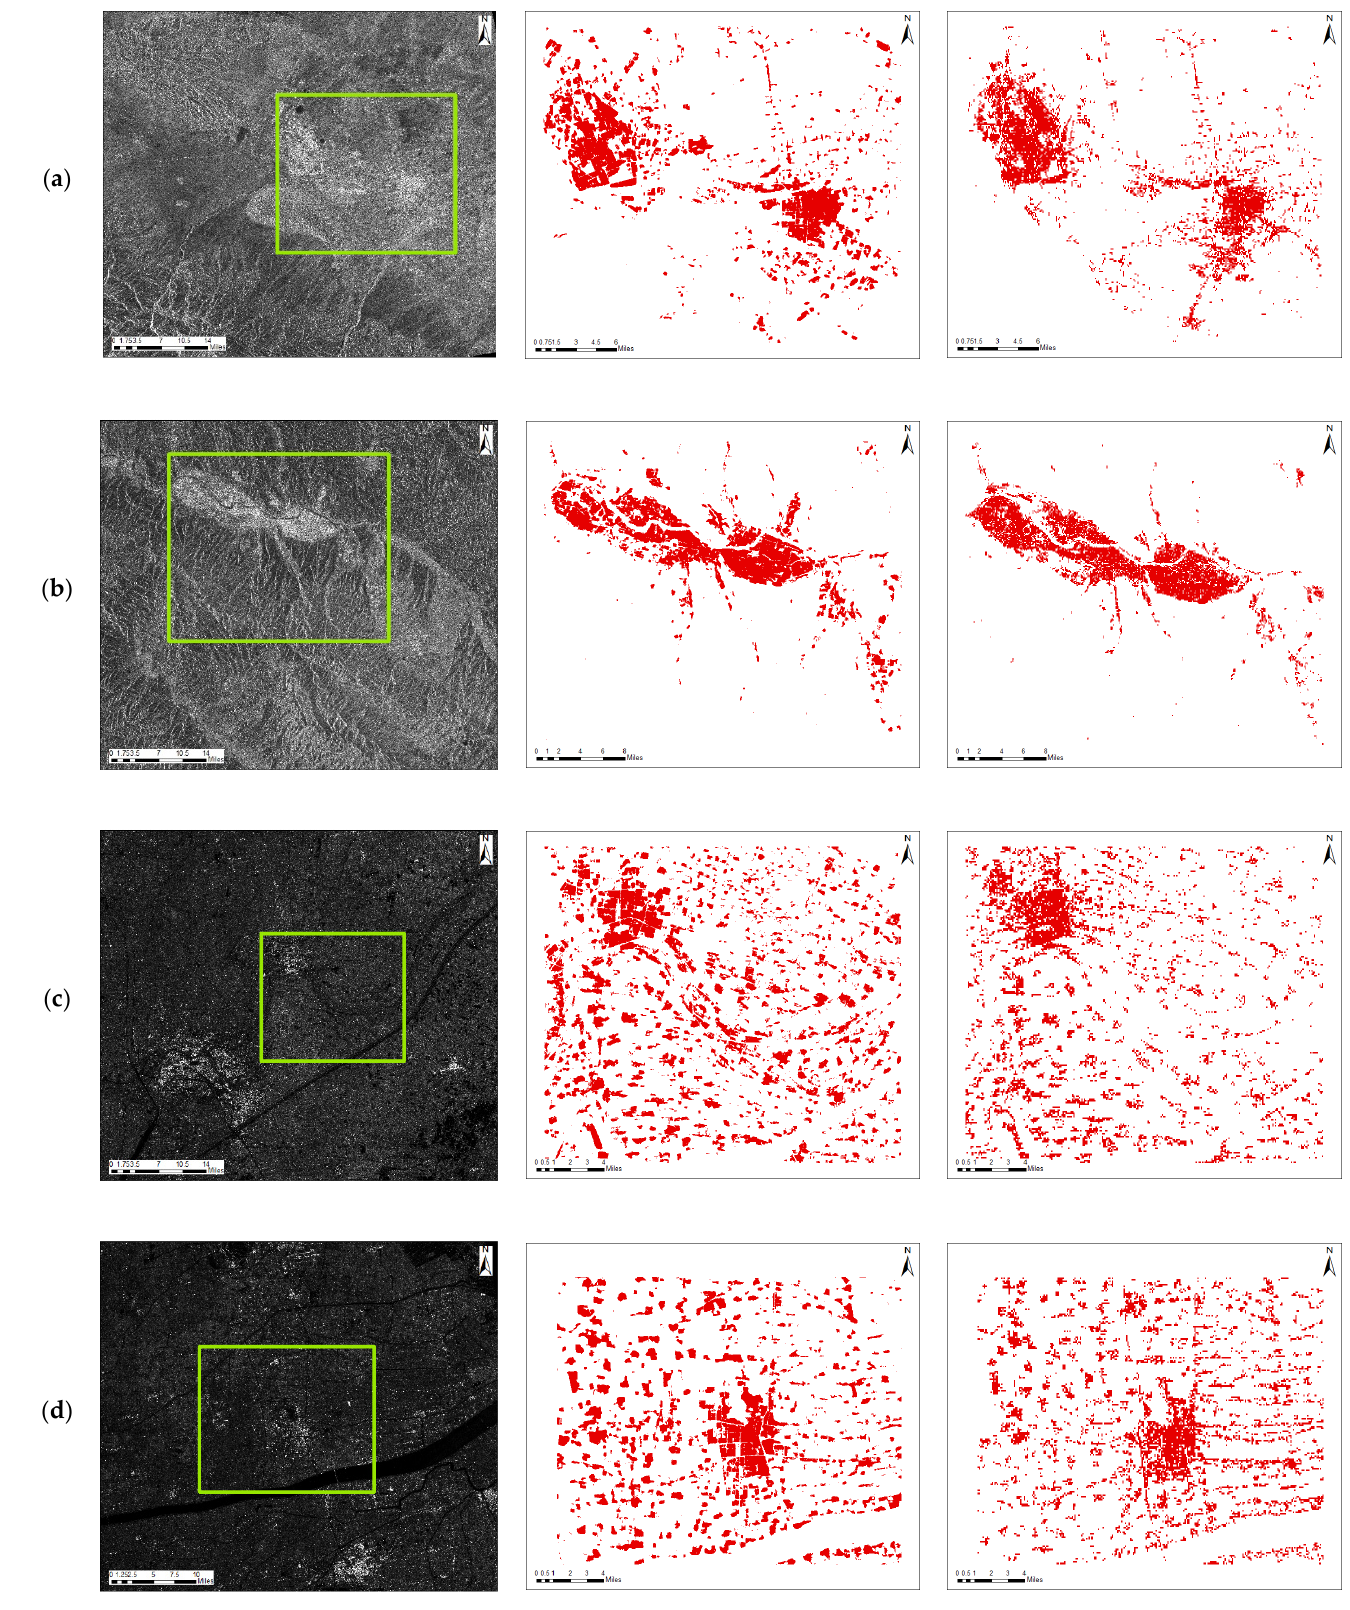
Figure 15. SAR images, BAs in our product, and BAs in the GUF: ( a , b ) Study areas in western China and ( c , d ) study areas in eastern China. The green box represents the area for comparison and accuracy